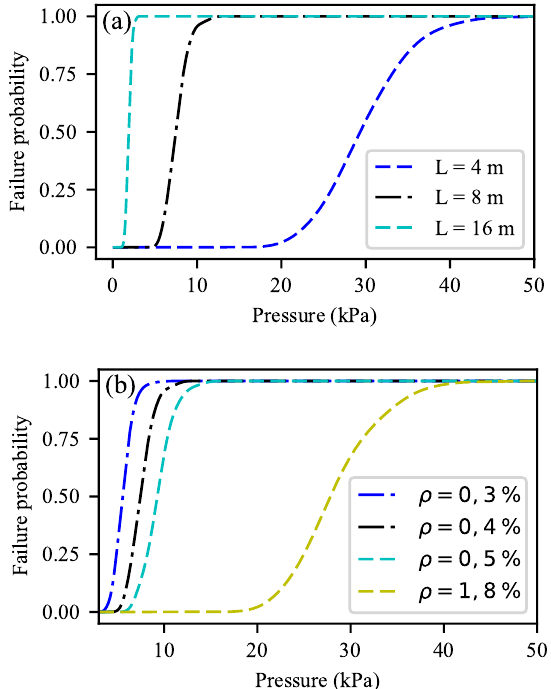
Figure 12. Effects on fragility curves (built with 300 data using the Gaussian Kernel Smoothing method) of the mean values of (a) the length of the RC wall, i.e., 4, 8 and 16m; and (b) the reinforcement ratio, i.e., 0.3%, 0.4%, 0.5%, and 1.8%.